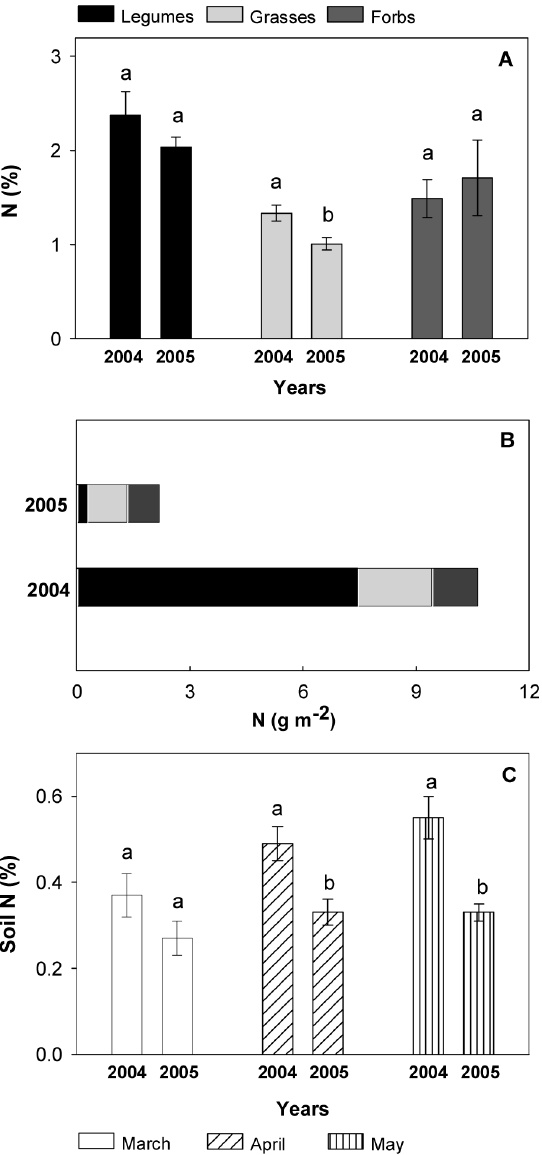
measurements.Fig. 4. N-concentration in legumes, grasses and forbs at the peak standing biomass in May 2004 and in May 2005 (A), amount of N reaching the soil with the peak mass of legumes, grasses and forbs (B), changes in N-concentration in soil gaps during the spring growth season